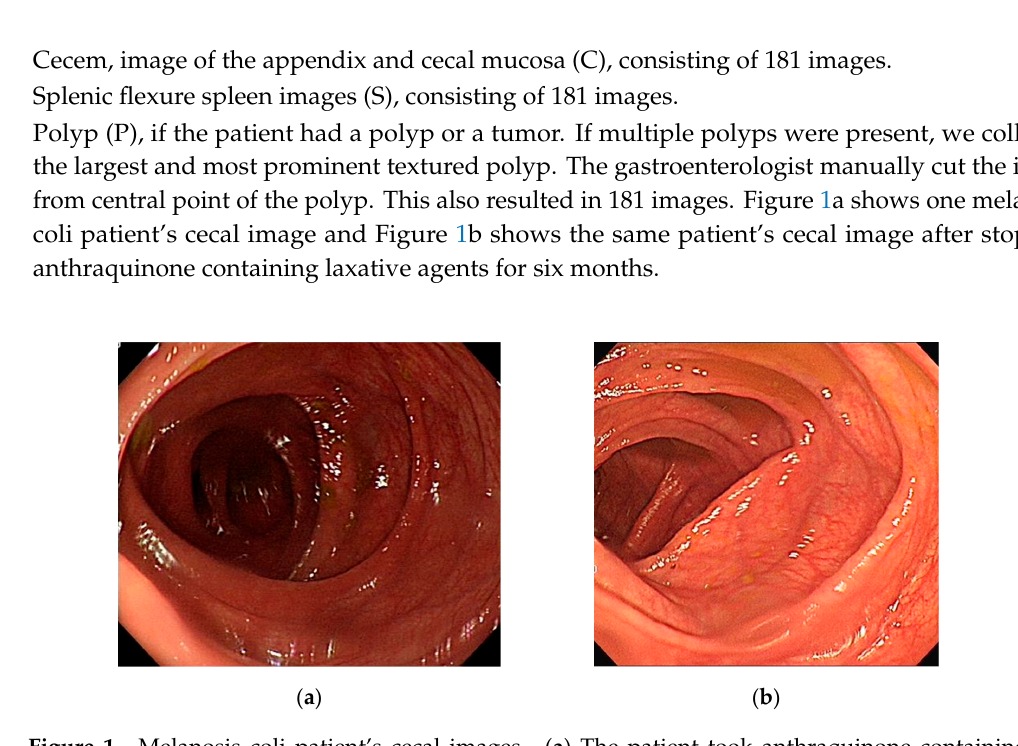
Figure 1. Melanosis coli patient’s cecal images. ( a ) The patient took anthraquinone containing laxative medicine one year and his colonoscopy image revealed blackish mucosal pattern in colon. ( b ) The same patient’s cecal image after six months. Blackish mucosal pattern disappeared after stopping anthraquinone containing laxative agent for 6 months.